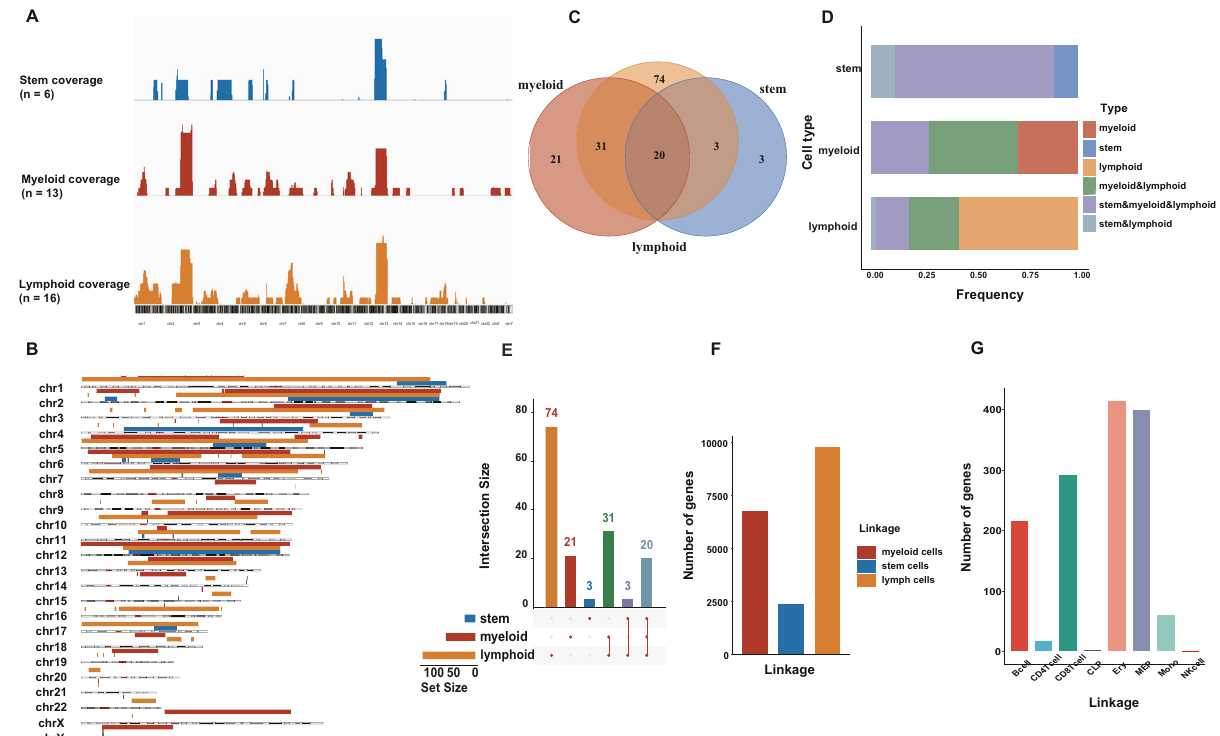
Fig. 3 EcDNA and ring chromosome in the normal stem, myeloid, and lymphoid cells. A The frequency of ecDNA and ring chromosome on a different chromosome. B Chromosome ideogram plot presented the distribution of ecDNA and ring chromosome across the stem ( n = 6), myeloid ( n = 13), and lymphoid ( n = 16) cells. C Venn diagram of overlapping ecDNA and ring chromosome. D The intersection size of overlapping ecDNA and ring chromosome in the stem, myeloid, and lymphoid cells, respectively. X-axis represents the cell type; Y-axis represents the intersection size. E The barplot identi fi ed the number of ecDNA and ring chromosomes in the overlap of different cells. X-axis represents the cell type; Y-axis represents the average number of ecDNA and ring chromosomes. F The average number of genes on ecDNA and ring chromosome in the stem, myeloid, and lymphoid cell, respectively. G The average number of genes on ecDNA and ring chromosome in B cell, CD4 + T cell, CD8 + T cell, CLP, Ery, MEP, Mono, and NK cell,